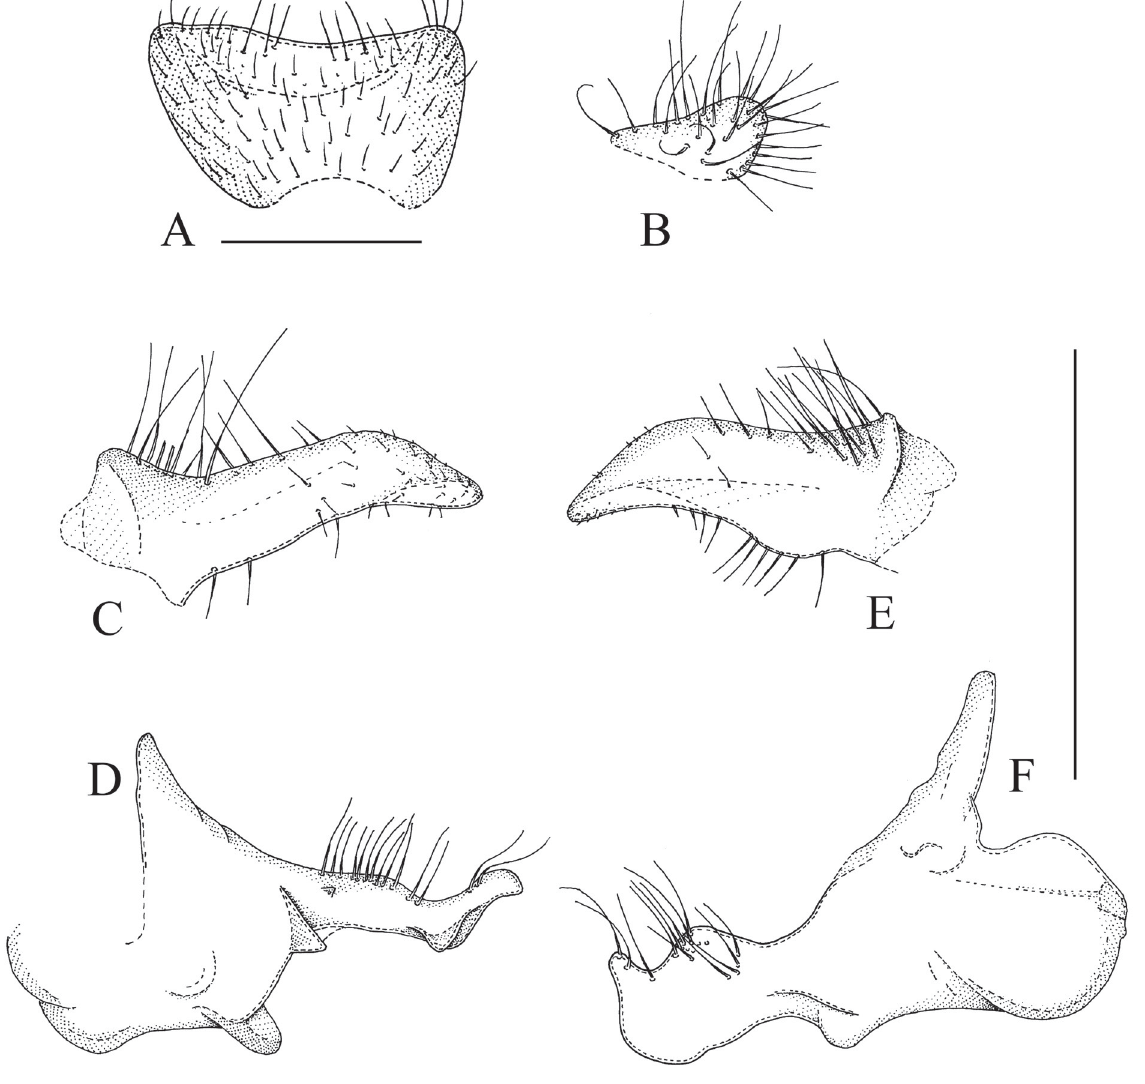
Fig. 32. Sphegina (Asiosphegina) fi mbriata sp. nov., holotype, ♂ . A . Sternum IV, ventral view. B . Left cercus, late ral view. C . Left surstylus, lateral view. D . Sternum IX and superior lobe, left side, lateral view. E . Right surstylus, lateral view. F . Sternum IX and superior lobe, right side, lateral view. Scale bars = 0.5